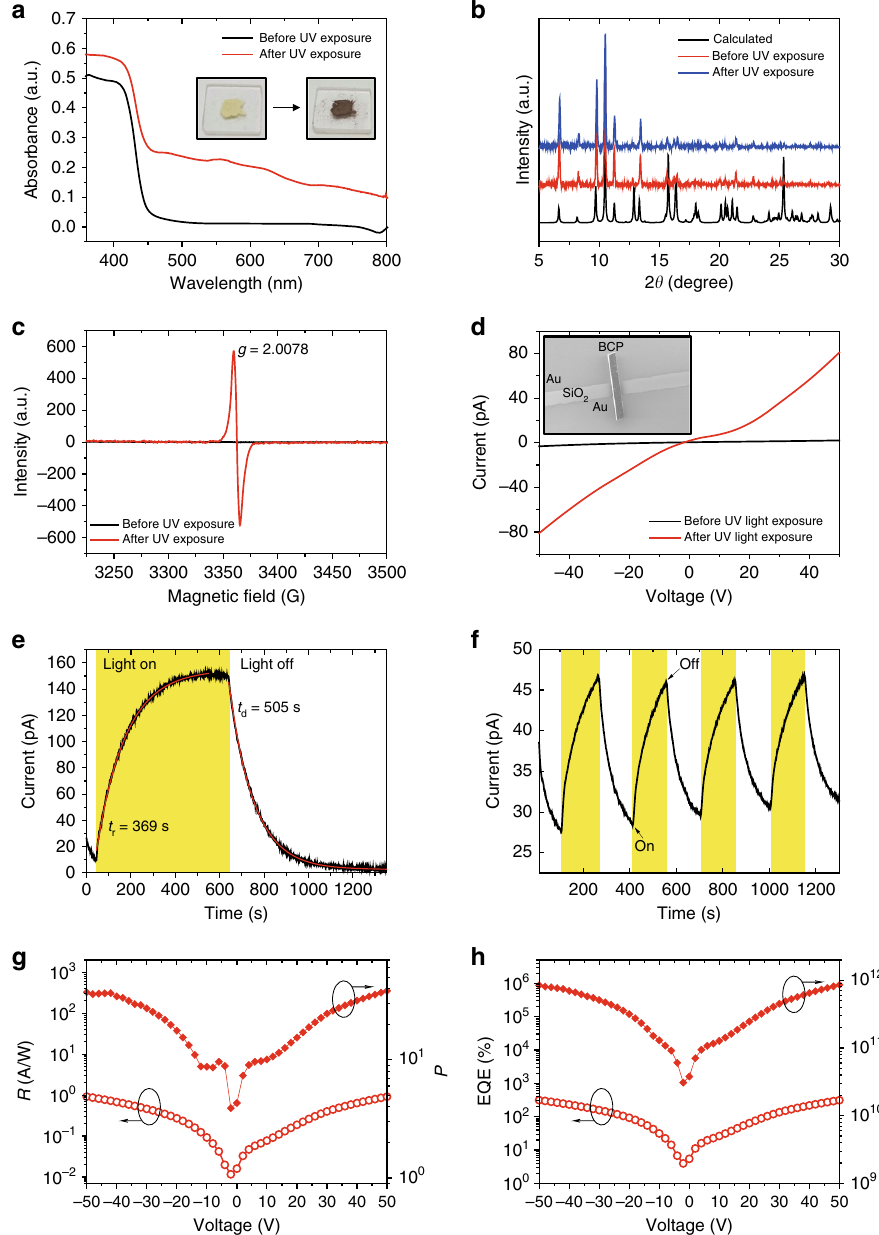
Fig. 3 Responses of heterochiral ( Rac )-AlaNDI-Zn SBCPs upon exposure to UV light. a UV – Vis spectra of ( Rac )-AlaNDI-Zn upon exposure to UV light ( λ = 365 nm, 150 μ W cm – 2 ). Insets show photographs of ( Rac )-AlaNDI-Zn before and after exposure to UV light for 1 h. b Calculated and experimental data of PXRD results for ( Rac )-AlaNDI-Zn upon exposure to UV light. c ESR results of heterochiral ( Rac )-AlaNDI-Zn SBCPs before and after exposure to UV light for 1 h. d I – V curves of heterochiral ( Rac )-AlaNDI-Zn SBCPs under UV light illumination. e , f Time-dependent conductivity changes in heterochiral ( Rac )-AlaNDI-Zn SBCPs under UV light for e rising and decaying time estimations and f reversible photoswitching results. g , h Photoresponsivity ( R